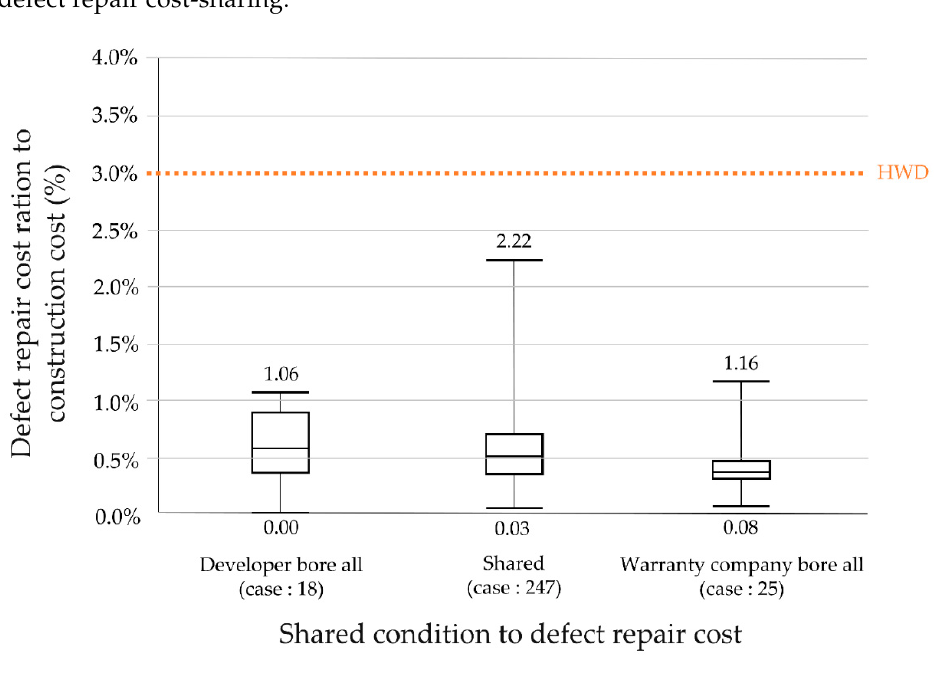
Figure 12. Comparison of damage sharing by the project entities.